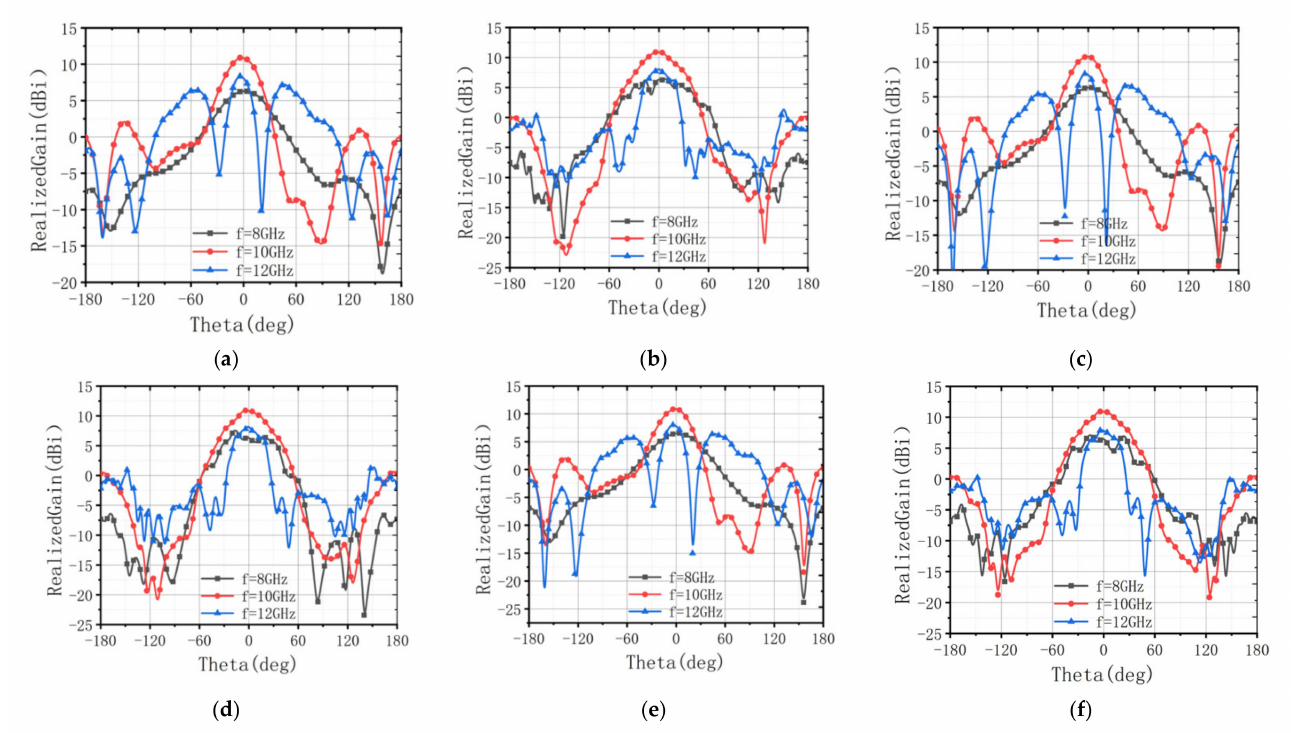
Figure A1. ( a ) E-Pattern of the second element. ( b ) H-Pattern of the second element. ( c ) E-Pattern of the third element. ( d ) H-Pattern of the third element. ( e ) E-Pattern of the fourth element. ( f ) H-Pattern of the fourth